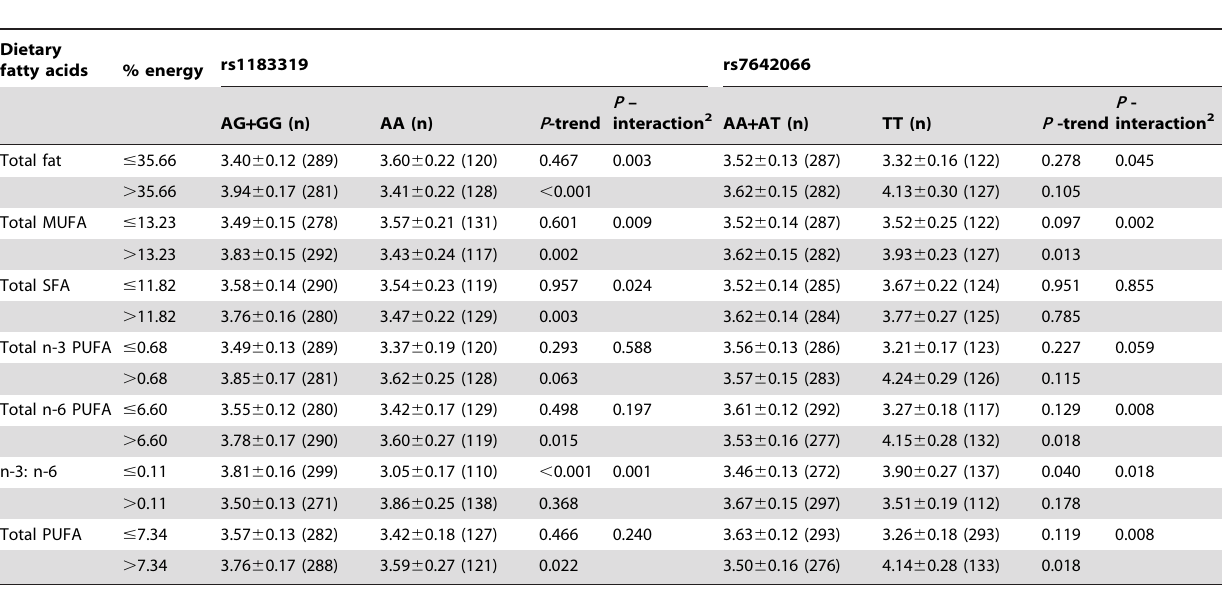
Table 3. Interactions between dietary fatty acids and PIK3CA-KCNMB3 variants on HOMA-IR in the GOLDN participants 1 .